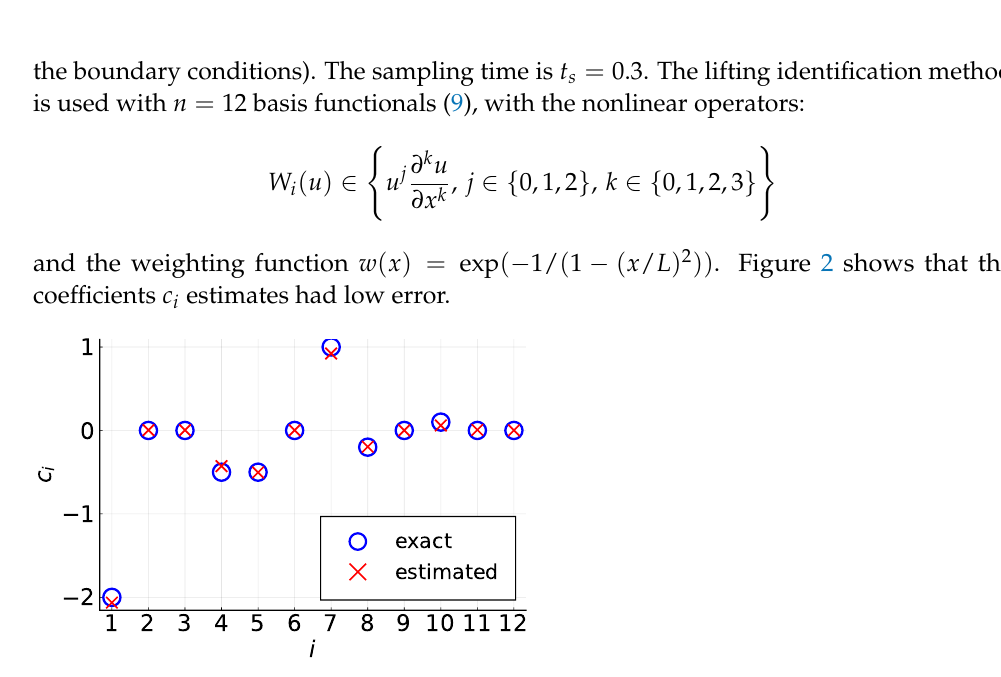
Figure 2. The lifting identification method is used to recover the PDE (18). The coefficients c i (blue circles) were estimated with low error (red crosses). Nonzero coefficients correspond to W 1 ( u ) = u , W 4 ( u ) = ∂ u / ∂ x , W 5 ( u ) = u ∂ u / ∂ x , W 7 ( u ) = ∂ 2 u / ∂ x 2 , W 8 ( u ) = u ∂ 2 u / ∂ x 2 , and W 10 ( u ) = ∂ 3 u / ∂ x 3